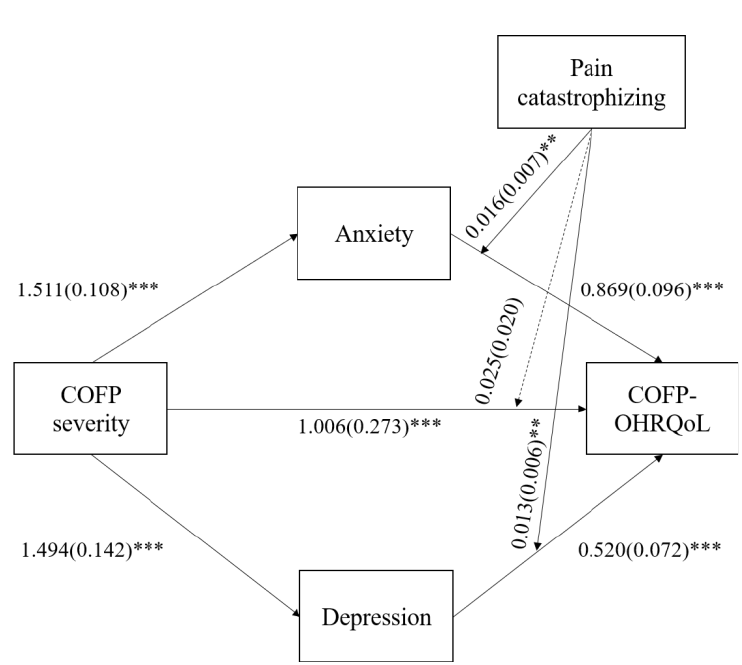
Figure 2. Diagram of the moderated mediation model. Note: Significant pathways are represented by solid arrows, and nonsignificant pathways are represented by dotted lines. Note: ** means p < 0.01; *** means p < 0.001.